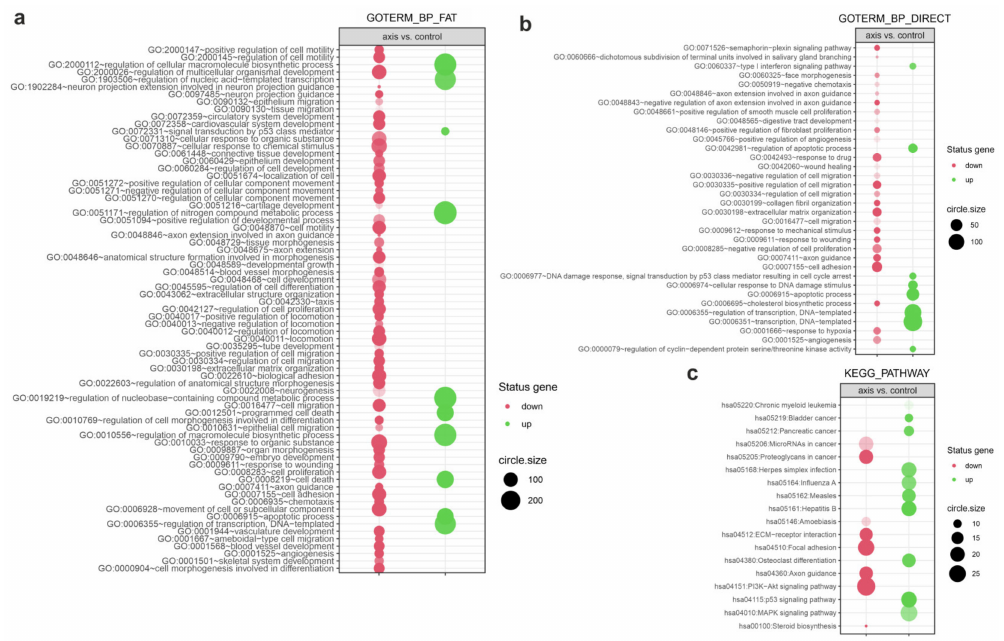
Figure 7. The processes differently regulated following irradiation of cells in the prostate. The bubble plot shows differently expressed gene sets in various databases—( a ) DAVID GO BP FAT database; ( b ) DAVID GO BP DIRECT database; ( c ) KEGG PATHWAY database—that were expressed differently between PNT1A cells irradiated in the axis vs. controls. The cut-off criteria were: |fold change| > 1.5 and ( a ) p value < 5 × 10 − 6 ; ( b , c ) p value < 0.05. The red and green bubbles represent downregulated and upregulated gene sets, respectively. The bubble size represents the number of genes regulating the gene set. The transparency of the bubble represents the p value (greater transparency denotes p values closer to the cut-off value). This analysis was based only on the differentially expressed